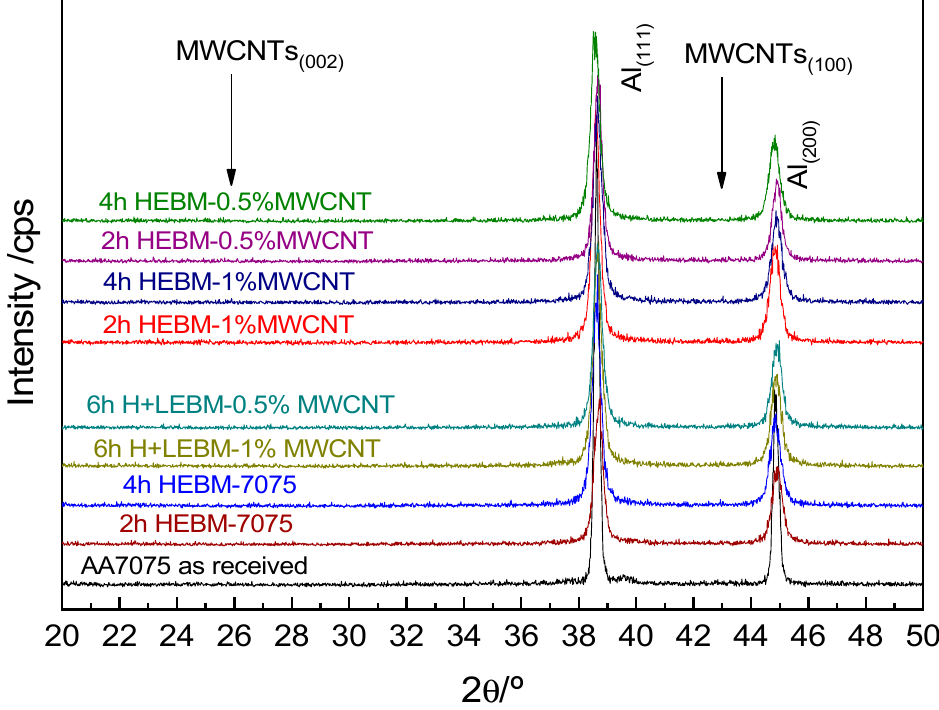
Figure 12. XRD diffractograms of AA7075-MWCNT composite powders with different MWCNT percentages milled through different routes compared to as-received AA7075 powders.